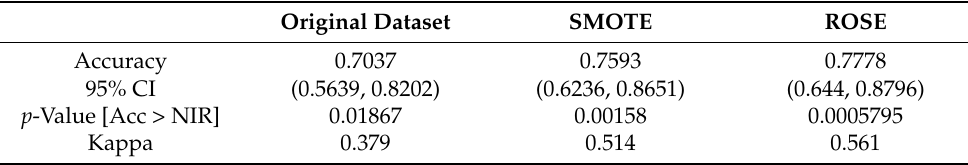
Table 6. Top 10 most contributing variables in the ROSE balanced Model C Table 5. Results of the Random Forest method on the Model C dataset.